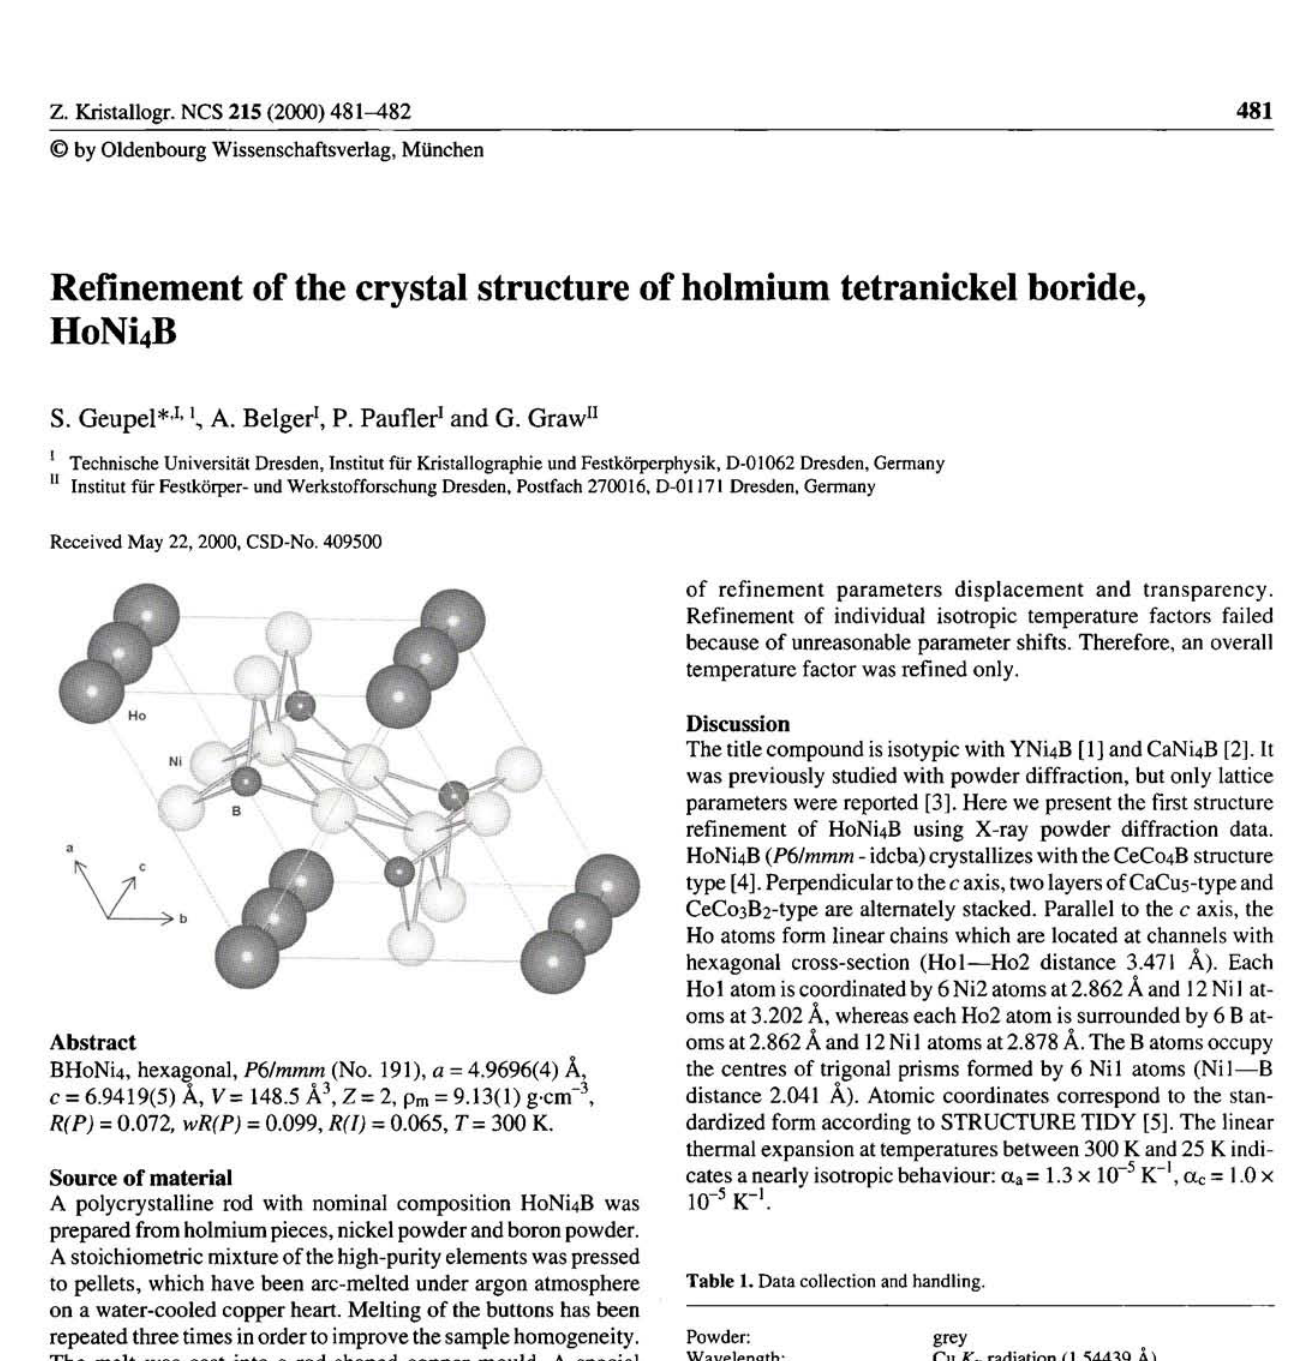
Table 2. Atomic coordinates and displacement parameters (in A 2